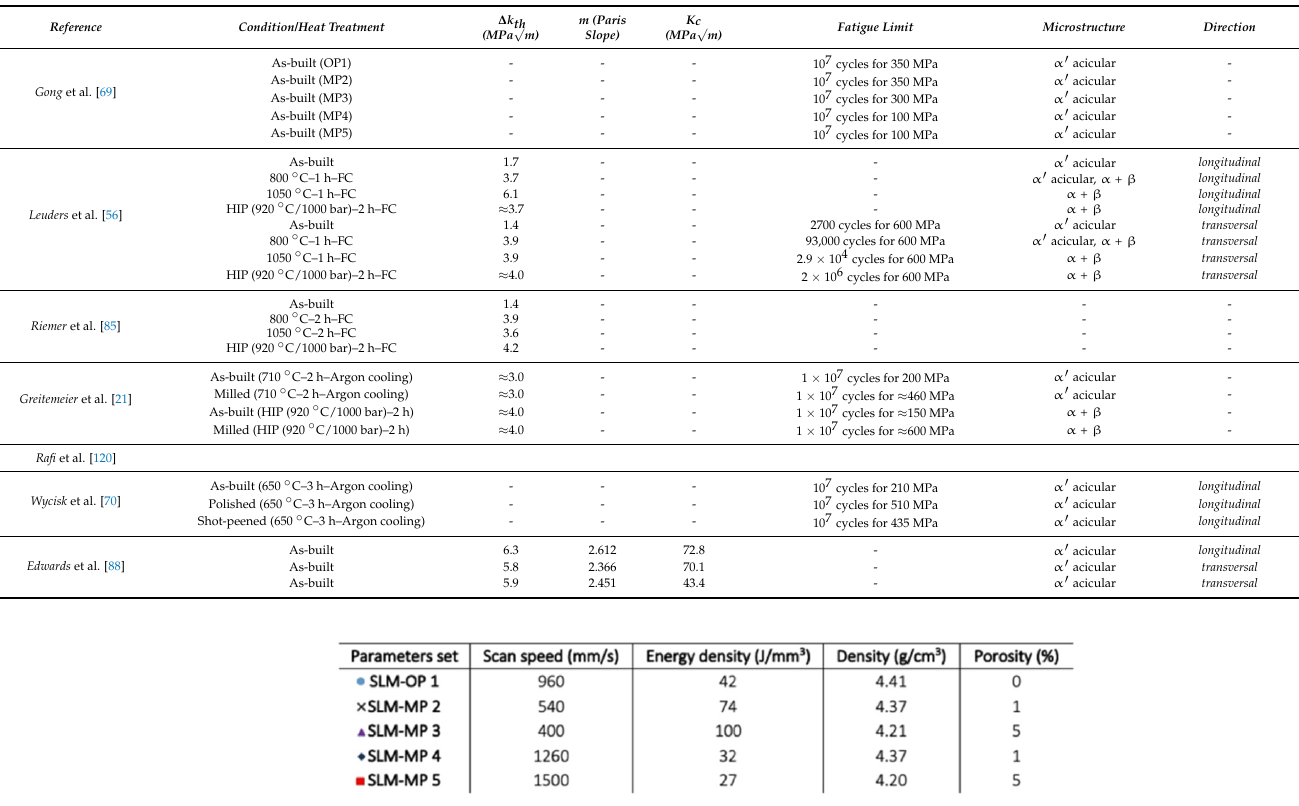
Table 5. High cycle fatigue properties of LPBF Ti6Al4V, indicating the testing direction with respect to the building direction (for a stress ratio of 0.1).